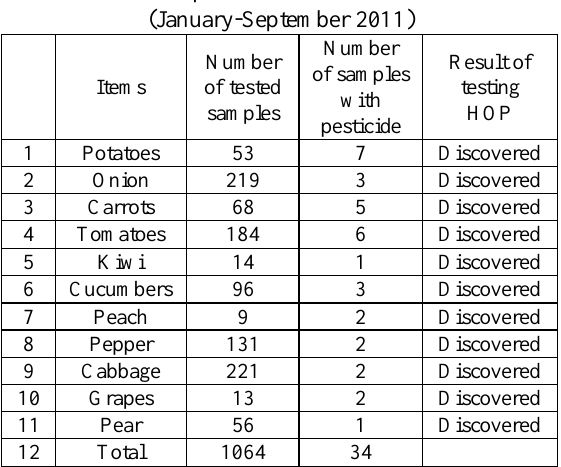
Table 1. Types and quantity of plant products with pesticide